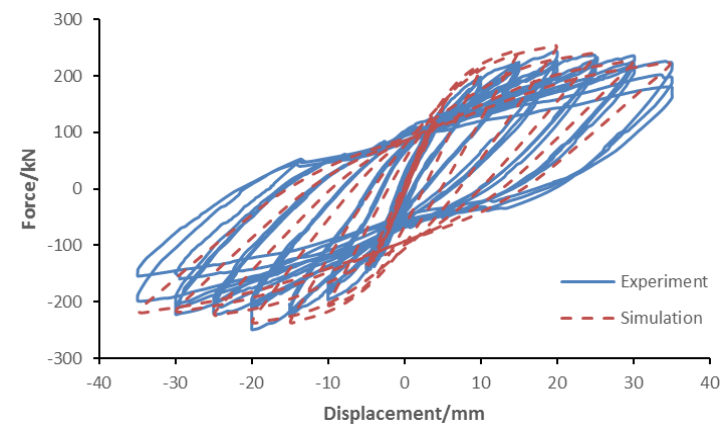
Figure15. Hysteretic curves.